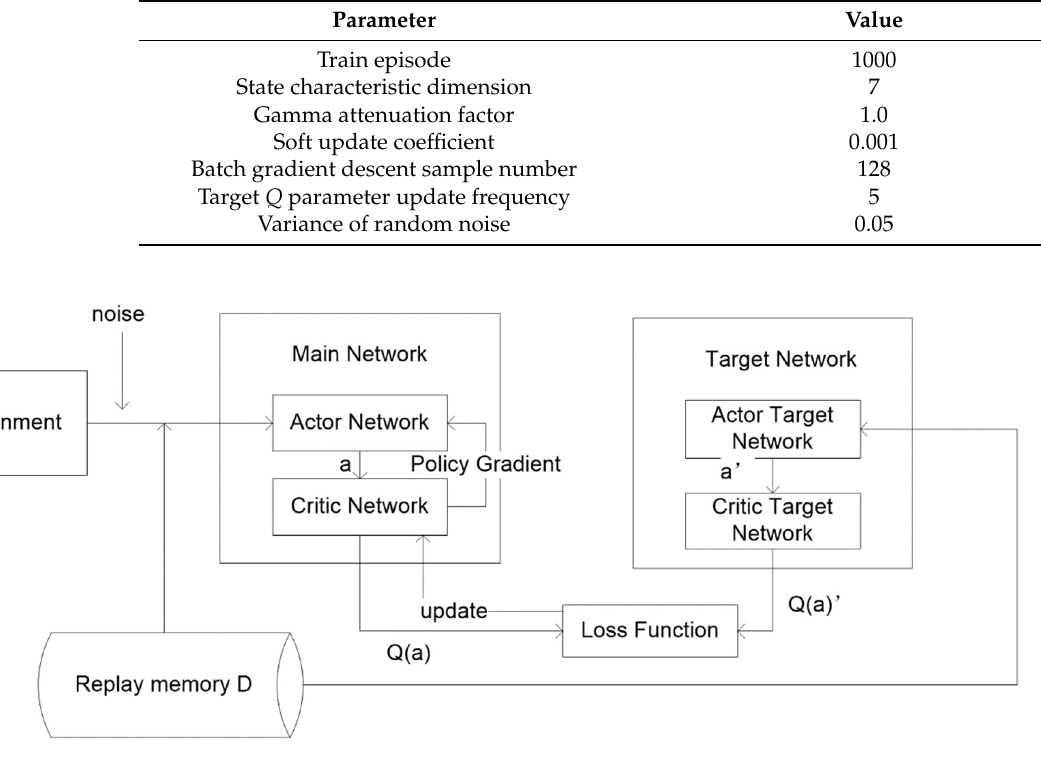
Figure 7. Flow Chart of DDPG method.